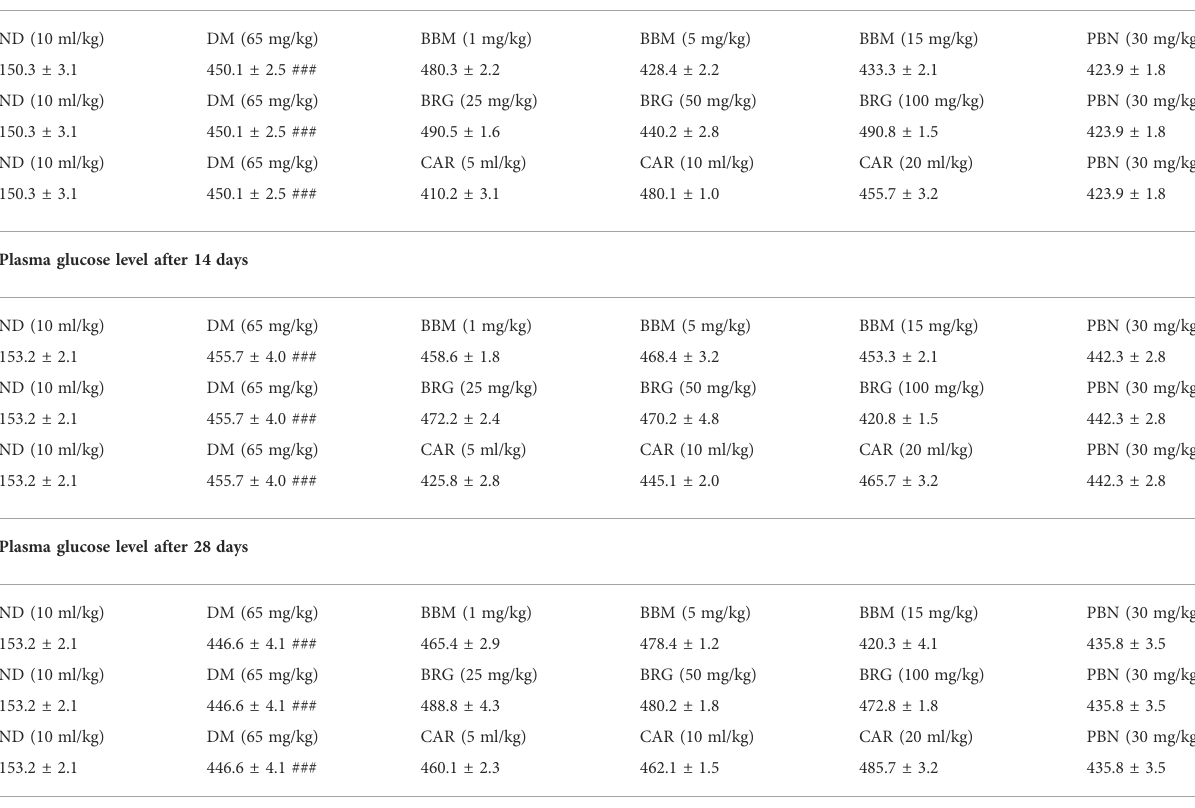
TABLE1Effectofberbamine(BBM),bergapten(BRG),carveol(CAR),andpregabalin(PBN)onbloodglucoselevel(mg/dl)ofratsat48 h,14thday,and 28th day after streptozotocin (STZ)-induced diabetic neuropathy. One-way ANOVA followed by post hoc Tukey test. ### p < 0.001 vs. sham.